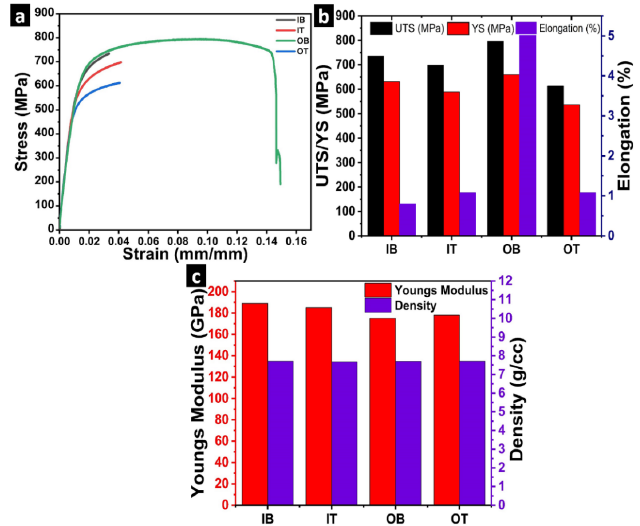
Figure 17. The ( a ) stress–strain curve of four different samples (IB, IT, OB, OT) and their corresponding ( b ) tensile properties and ( c ) density and young’s modulus plot.